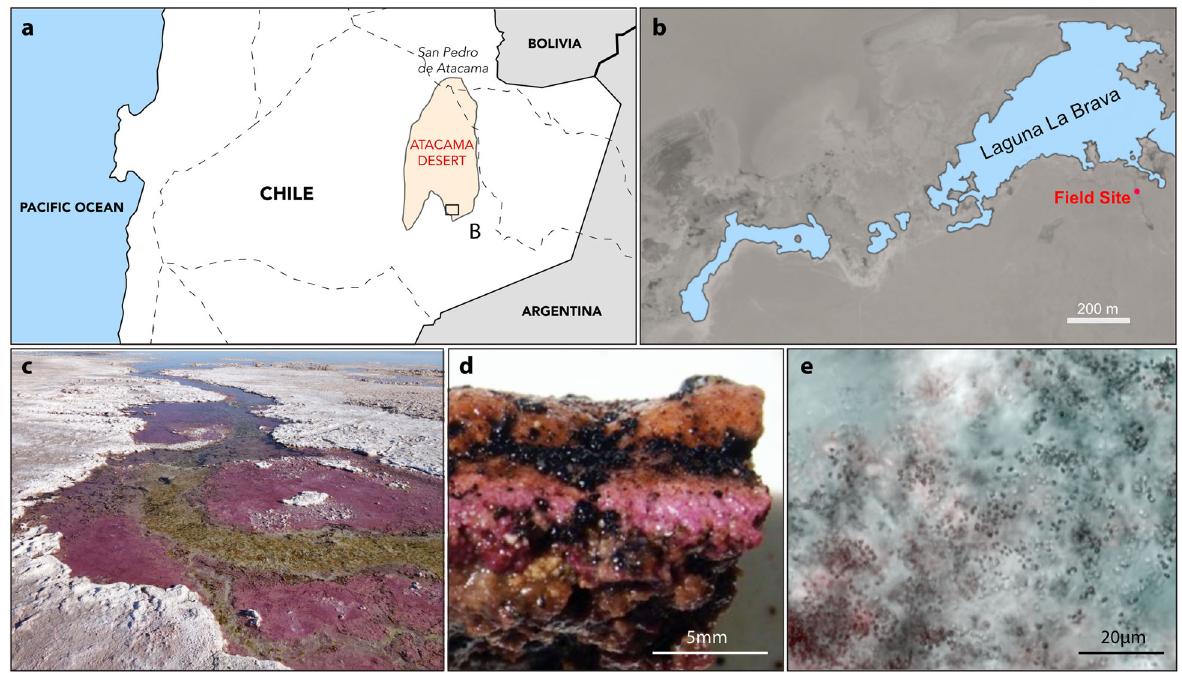
Fig. 1 Laguna La Brava Channel mats. Description of the fi eldsite: a Map of Northern Chile; b Detail of frame ( a ) showing Laguna La Brava in the southern Atacama; paleoshorelines visible to the north; c The channel showing the mats (purple); channel width in foreground is about 3 m; d Hand sample in cross section of studied mat; e Phase-contrast microscopic image showing Ectothiorhodospira -like bacteria from purple layer (see frame, d